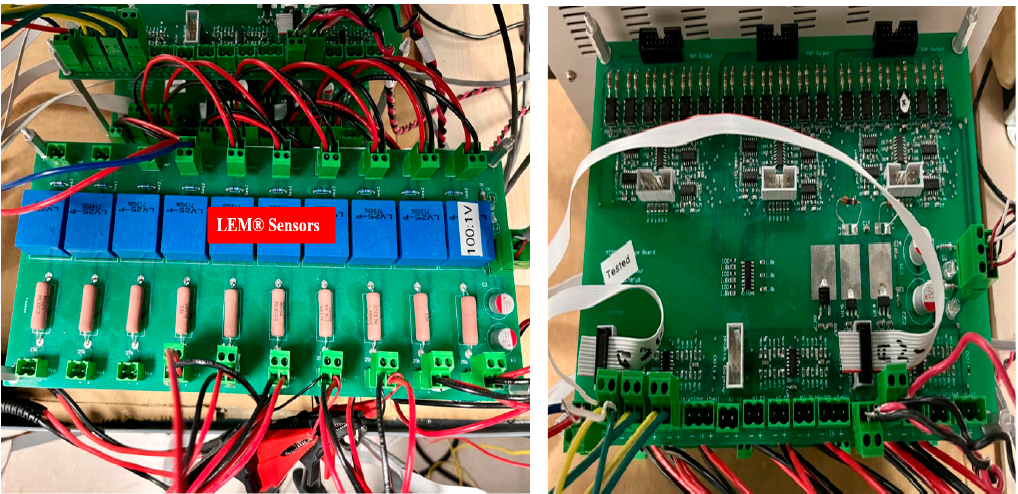
Figure 13. Sensor ( left ) and signal conditioning ( right ) board of the MMC prototype.